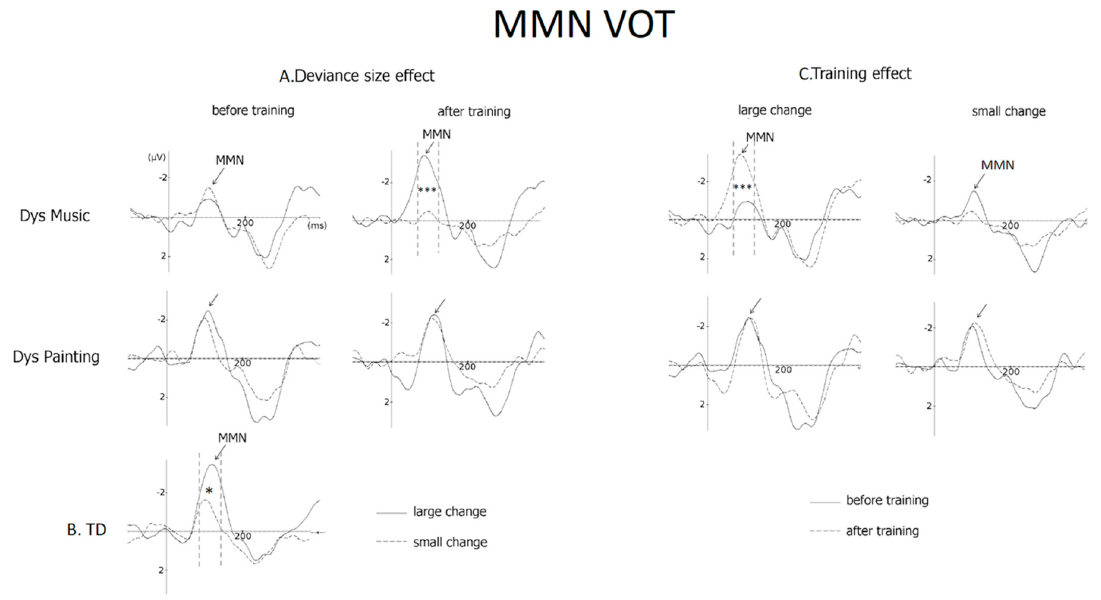
Figure 3. Mismatch Negativities (MMNs) to Voice Onset Time (VOT) deviant stimuli at Fz. ( A ) The deviance size effect (i.e., the difference in MMNs mean amplitude between large and small deviant stimuli) is illustrated before and after training for children with dyslexia trained with music (DysMus, top) or with painting (DysPaint), middle) and ( B ) for Typically Developing children (TD). ( C ) The training effect to large and small changes in VOT is illustrated before (solid lines) and after training (dashed line) for children with dyslexia in the music and in the painting groups.